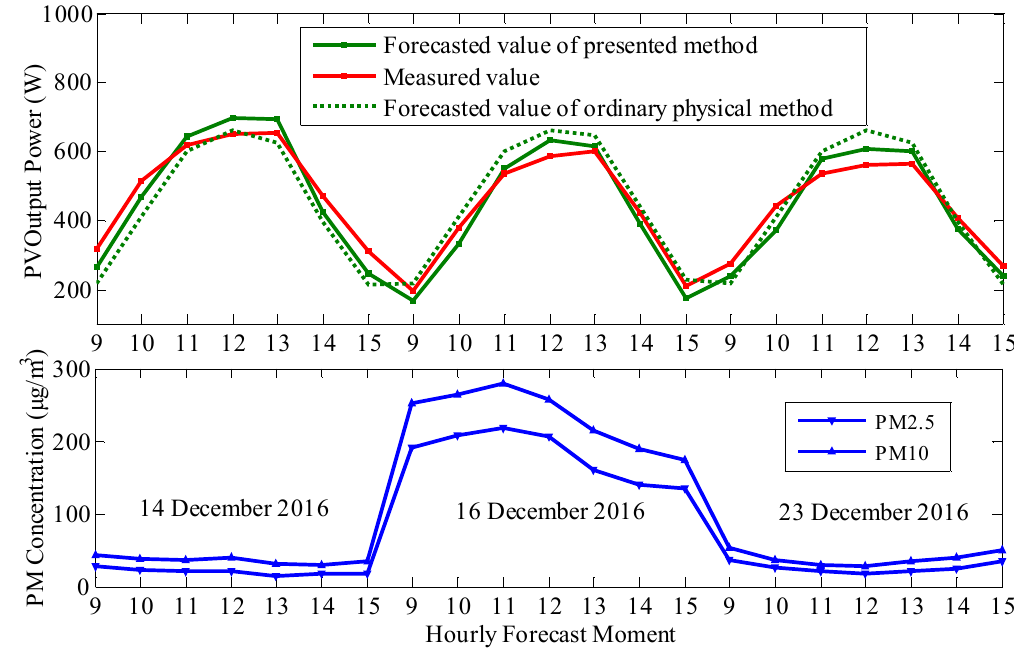
Figure 15. Energies 2018 , 11 , x